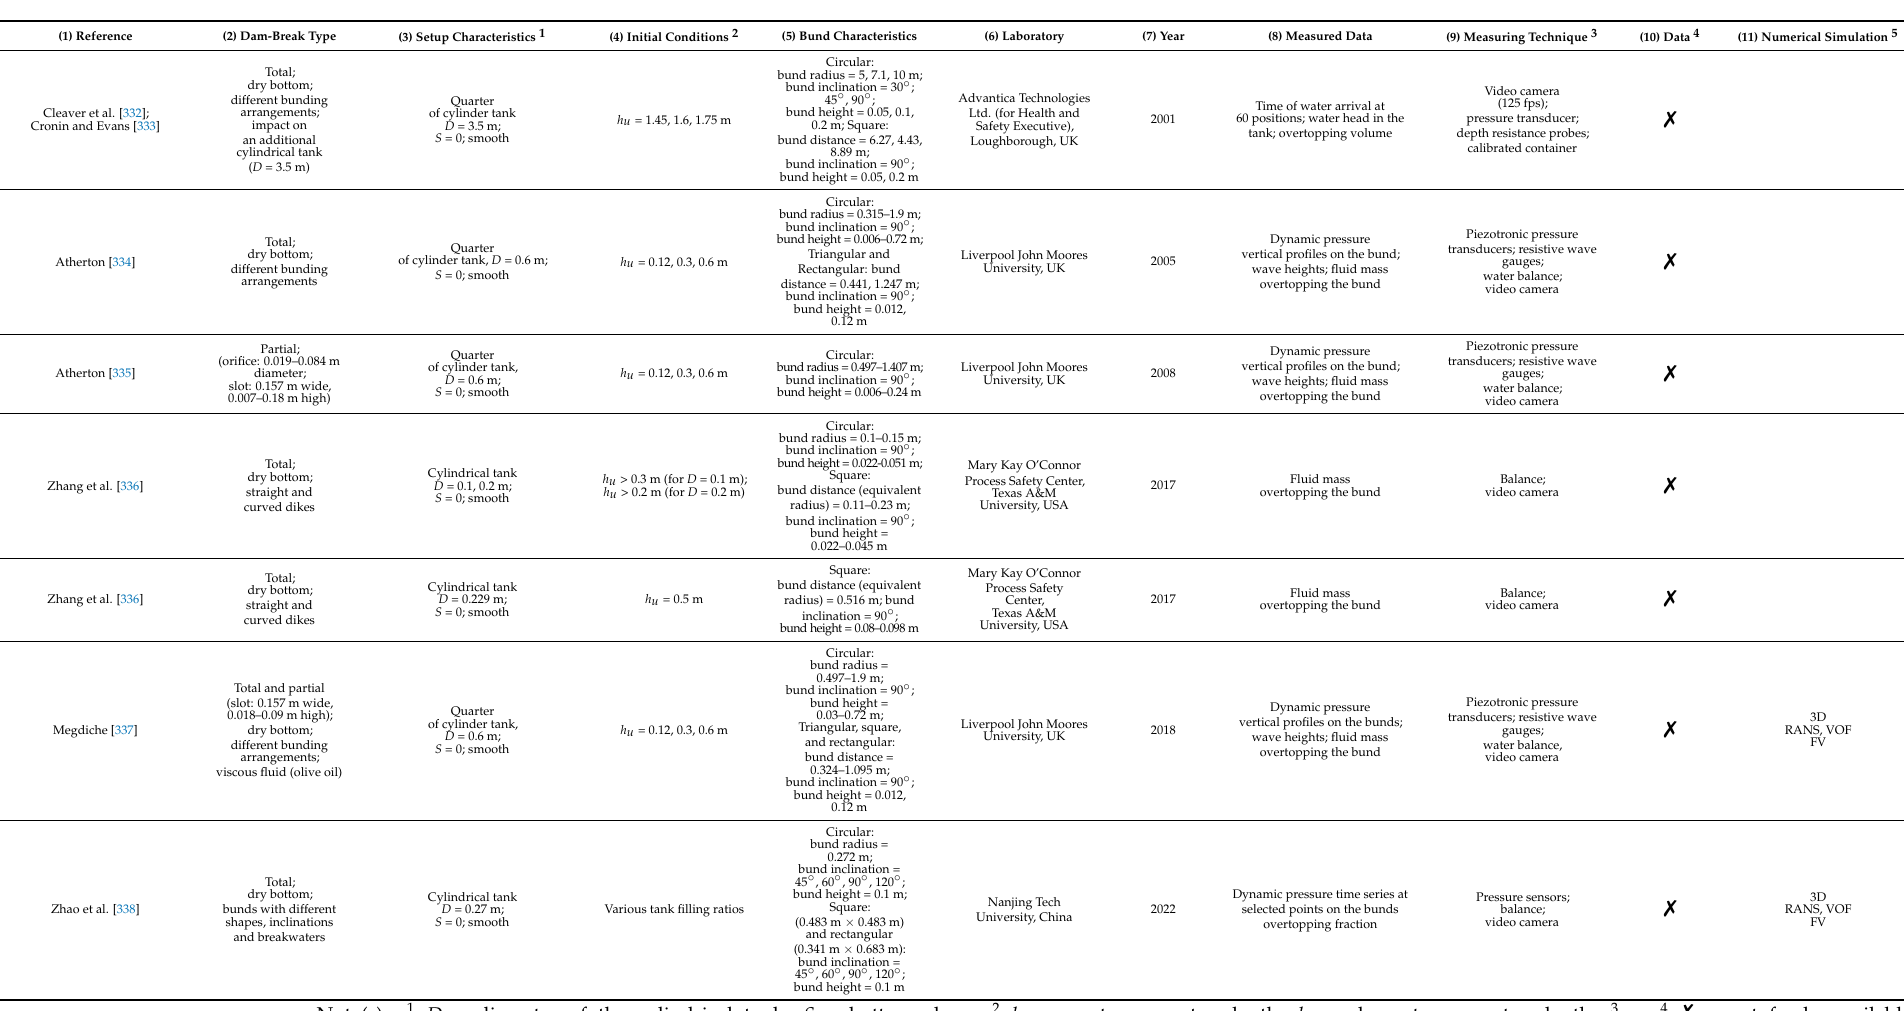
Table 1. Basic experimental investigations of fundamental dam-break wave physical characteristics.